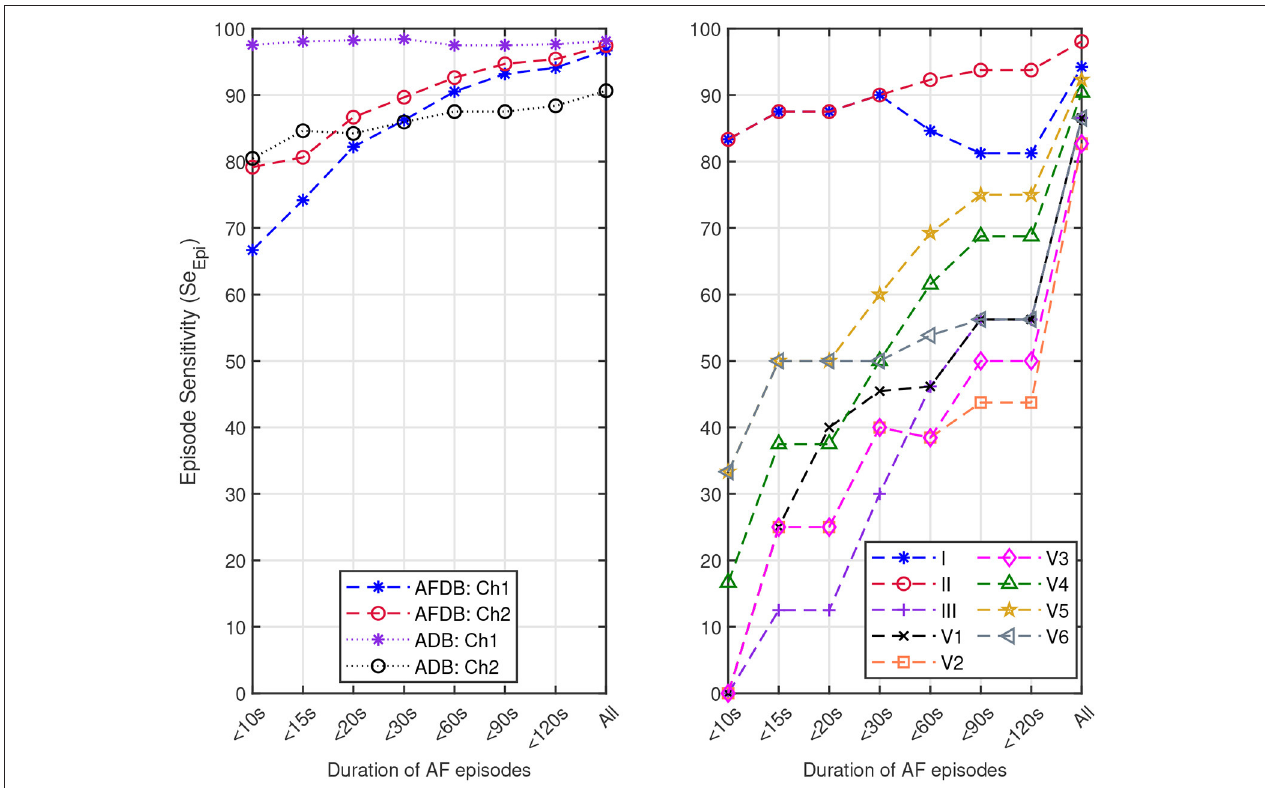
FIGURE 7 | Episode sensitivity achieved on the episodes shorter than a particular duration present in: (left) channel 1 (Ch1) and channel 2 (Ch2) of the AFDB and Arrhythmia DB (ADB), respectively, and (right) leads I, II, III, V1, V2, V3, V4, V5, and V6 of the Monzino-AF